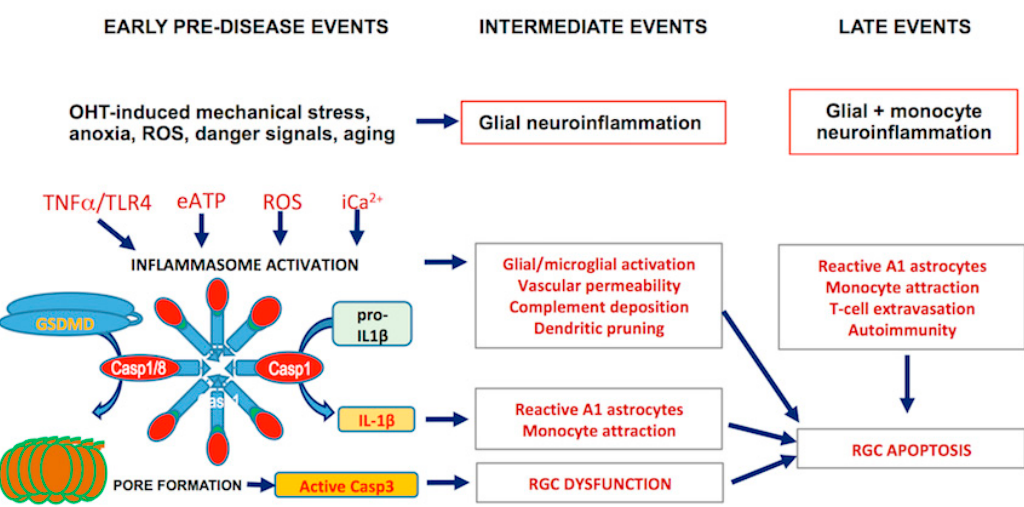
Figure 3. Schematic representation of the temporal sequence of molecular events during the development and progression of glaucomatous damage in the retina.